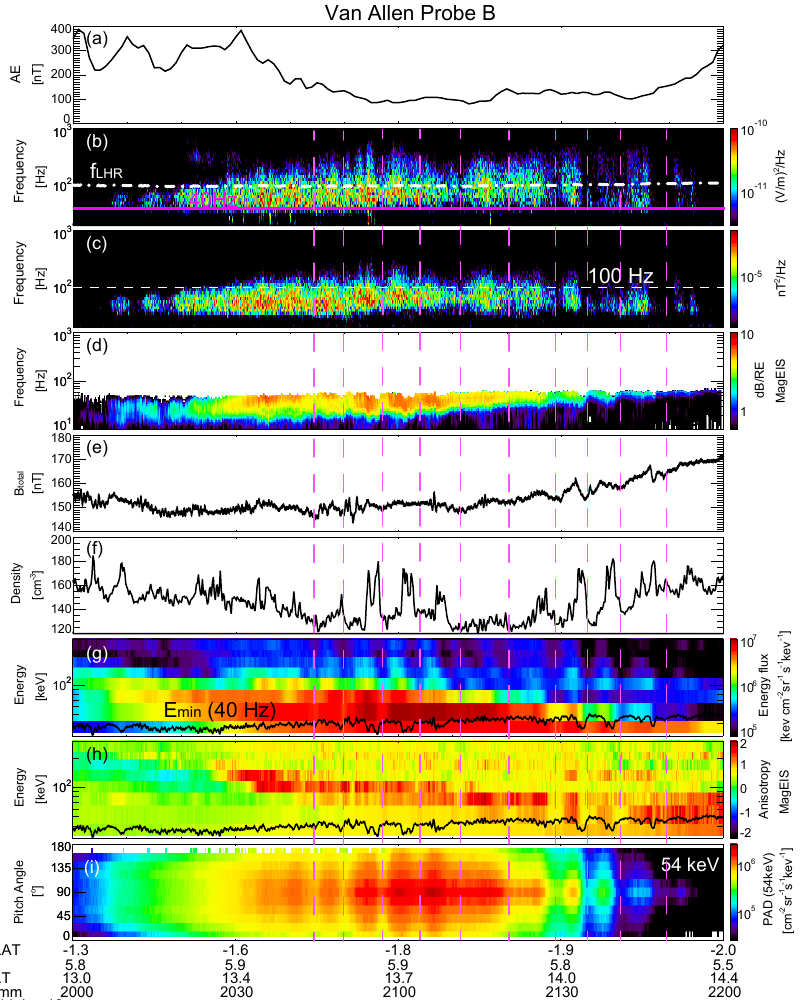
Figure 1. Plasmaspheric hiss modulation caused by injected electrons observed by Van Allen Probe B from 20:00 to 22:00UT on 12 Jan- uary 2014. (a) AE index; frequency-time spectrogram of (b) wave electric field and (c) wave magnetic field spectral density in the WFR channel; (d) frequency spectrum of convective linear wave growth rates; (e) background magnetic field intensity; (f) calibrated plasma den- sity based on EFW and EMFISIS; (g) spin-averaged electron flux measured by MagEIS; (h) electron pitch angle anisotropy; (i) pitch angle distribution of electrons at 54keV. The white dash-dotted line in (b) represents the lower hybrid resonance frequency ( f LHR ) . The magenta line in (b) indicates 40Hz. The white dashed line in (c) indicates 100Hz. The black lines in (g, h) represent the minimum resonant energy of electrons interacting with the waves at 40Hz. The dashed vertical lines mark the modulation of the electron flux at 54keV (i)